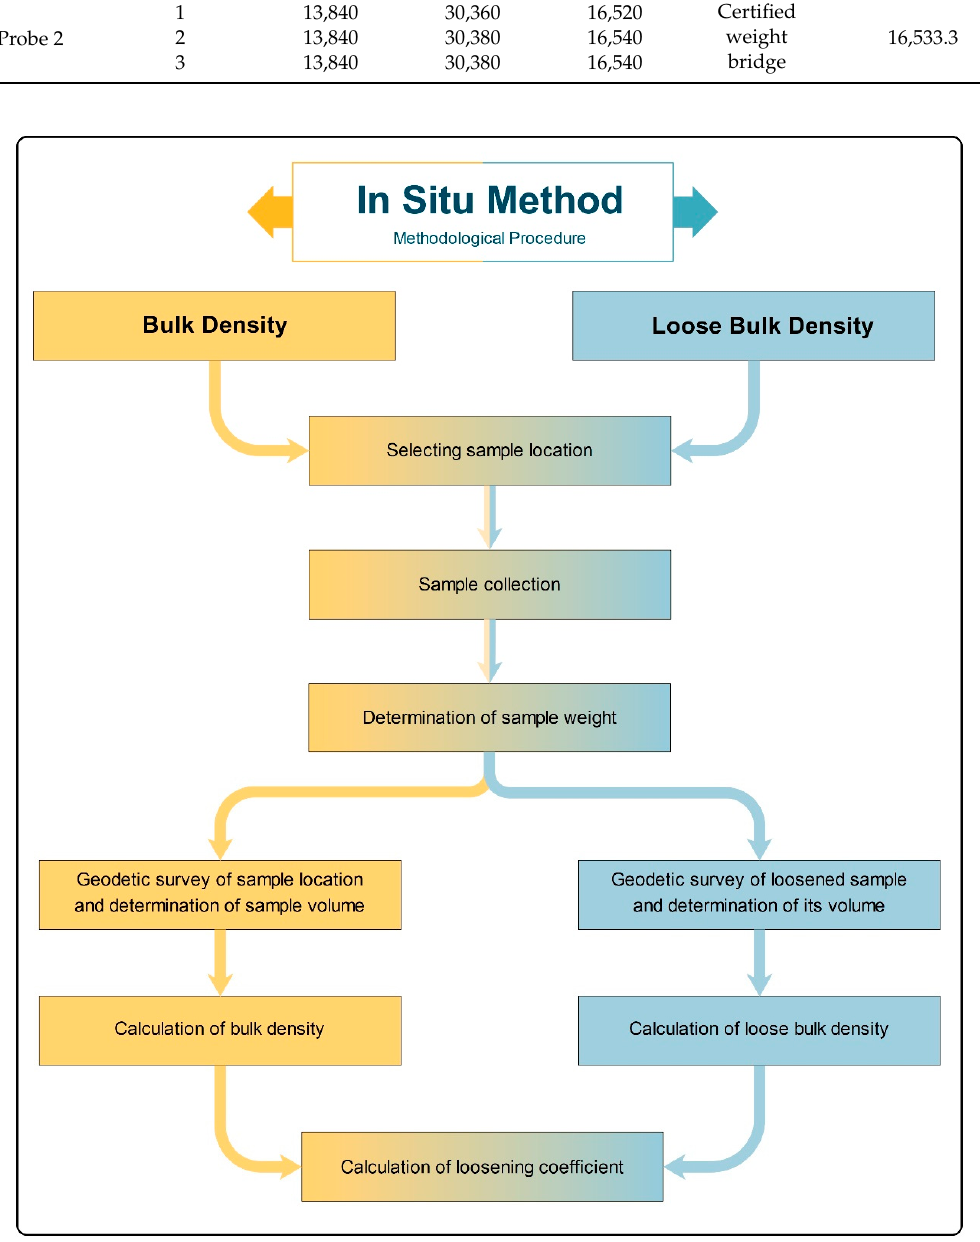
Figure 4. Methodological procedure for the determination of bulk density and loose bulk density by the in situ method.